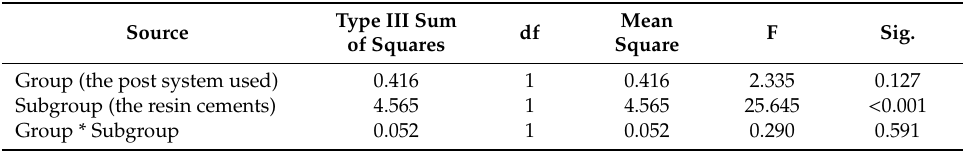
Table 1. The two-way ANOVA for the post systems, the resin cements, and the interaction terms, according the push-out bond strength (MPa).